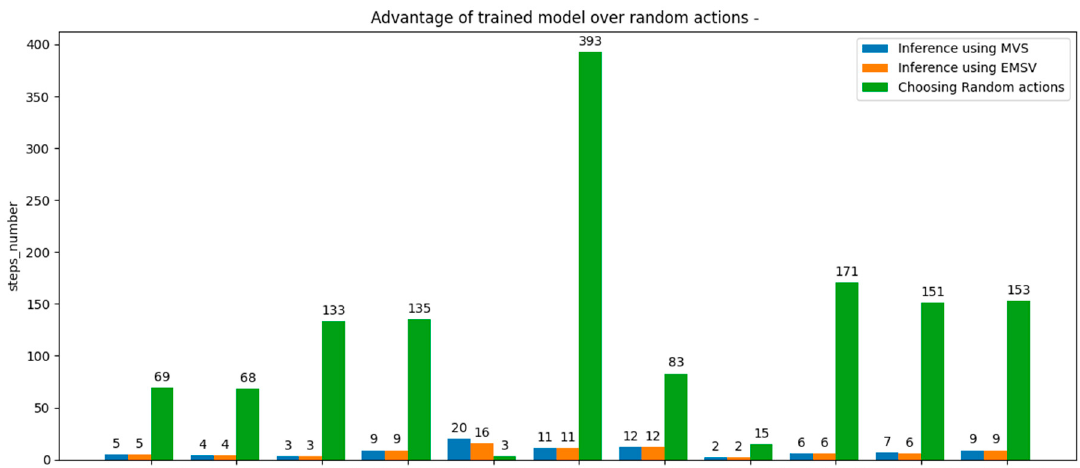
Figure 8. Inference process results on a trained agent model with the third reward scheme, where the MVS and EMVS mechanisms were applied one by one, compared with randomly choosing actions until the desired terminal state was reached. The last number in the description of each group of bars represents the initial state for the respective inference process.